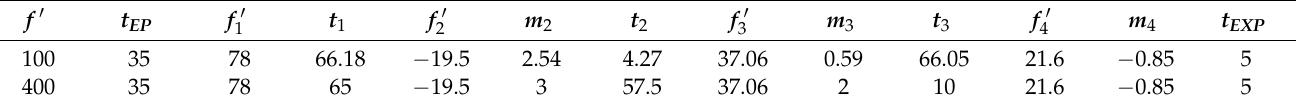
Table 2. Initial lens structure of the 4 × zoom objective (unit: mm).